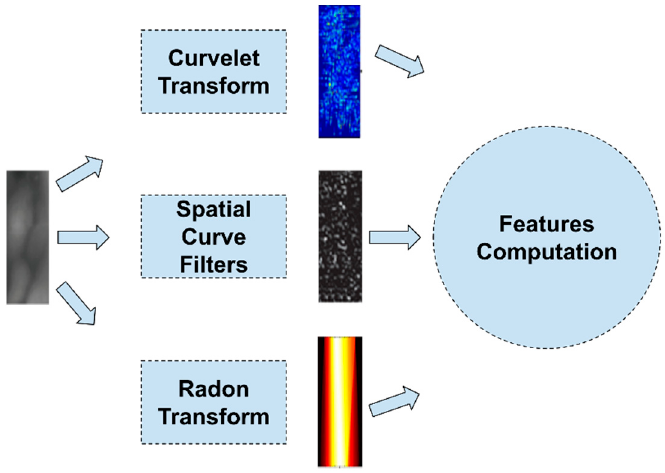
Figure 6. Feature extraction using image-transformation-based features.